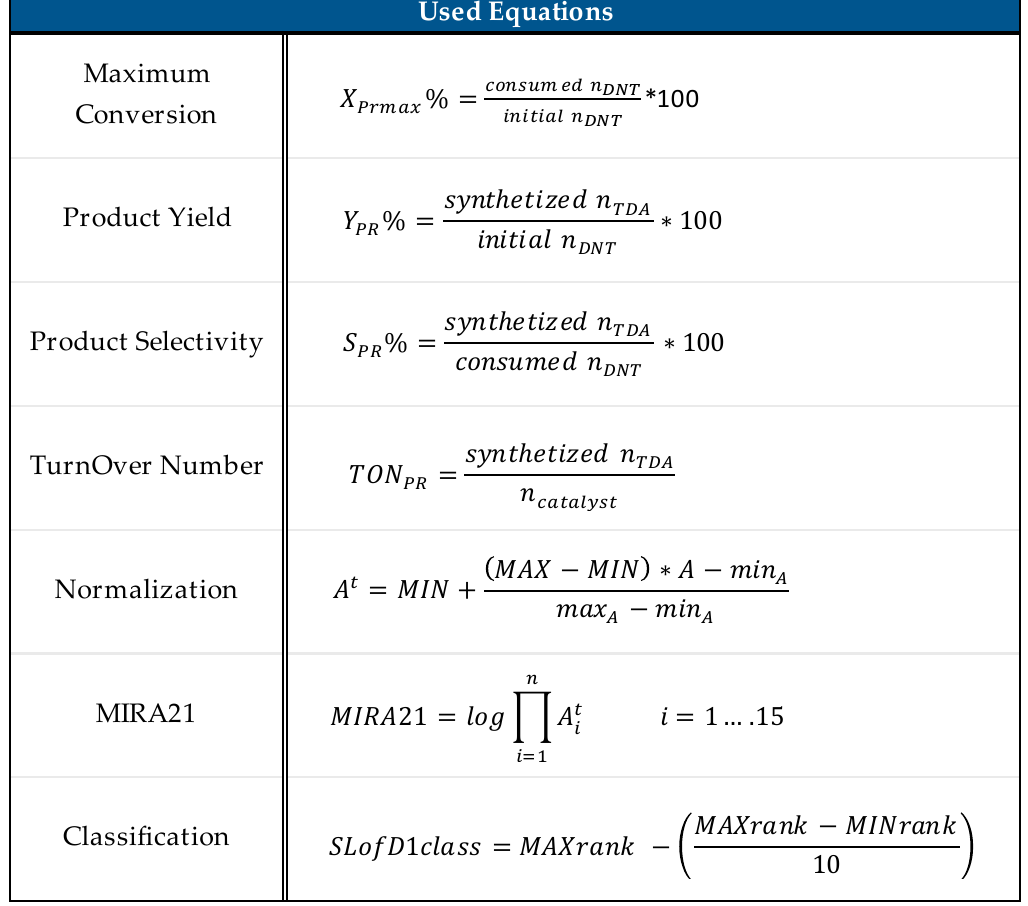
Figure 14. MIRA21 used equations [24].